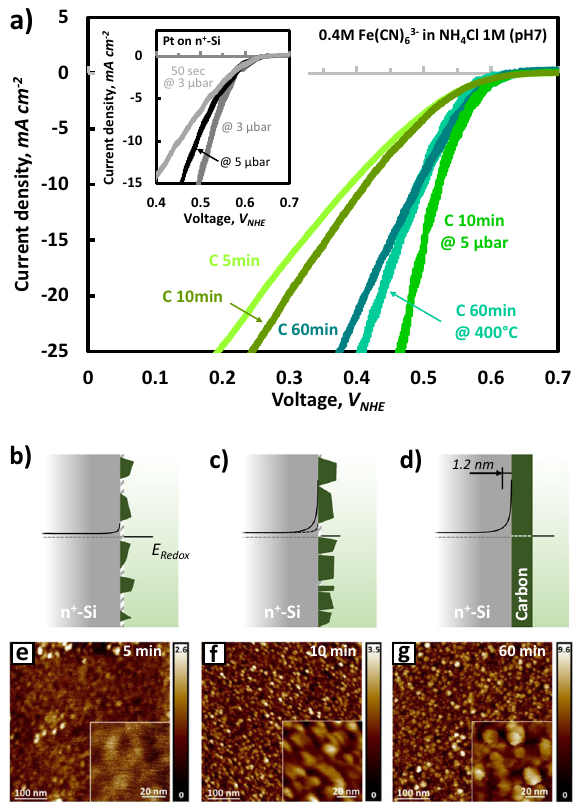
Fig. 3 LSVs of c-Si electrodes with carbon conducting layer. LSVs for the carbon layers deposited under various conditions (e.g. deposition duration and working pressure of the sputtering) ( a ). LSVs for the samples with Pt conducting layers are also demonstrated in the inset. For notational simplicity, ‘ min ’ , ‘ sec ’ , and ‘ μ bar ’ correspond to the deposition time and pressure of the sputtering chamber, respectively. The cross-sectional schematic of the electrode with various carbon coverages are also illustrated here ( b – d ). AFM images showing carbon islands distribution and size variation with deposition time ( e – g